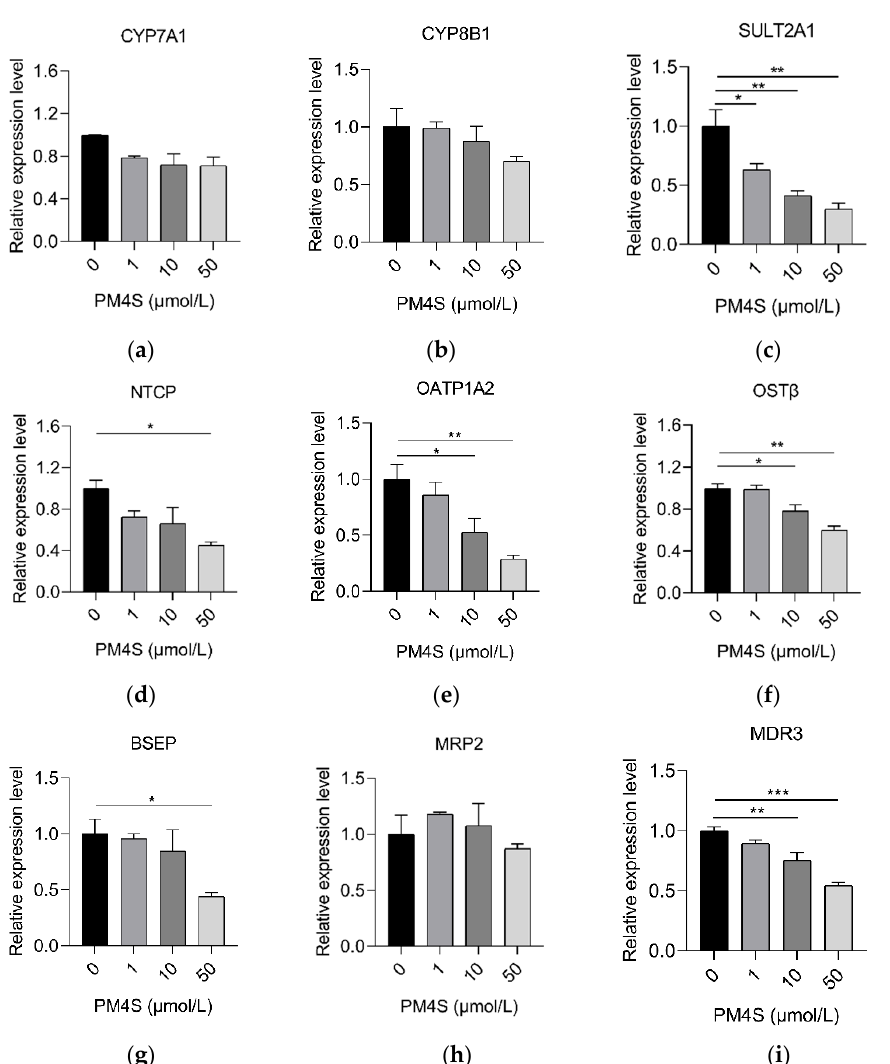
Figure 6. Relative expression mRNAs of pig primary hepatocytes involved in ( a , b ) BA synthesis, ( c ) BA sulfation, ( d , e ) BA reabsorption, ( f ) BA efflux, ( g , h ) BA biliary secretion, and ( i ) phosphatidyl- choline secretion, respectively. n = 3/group. Data are shown as means ± SE, * p < 0.05, ** p < 0.01, *** p < 0.001.